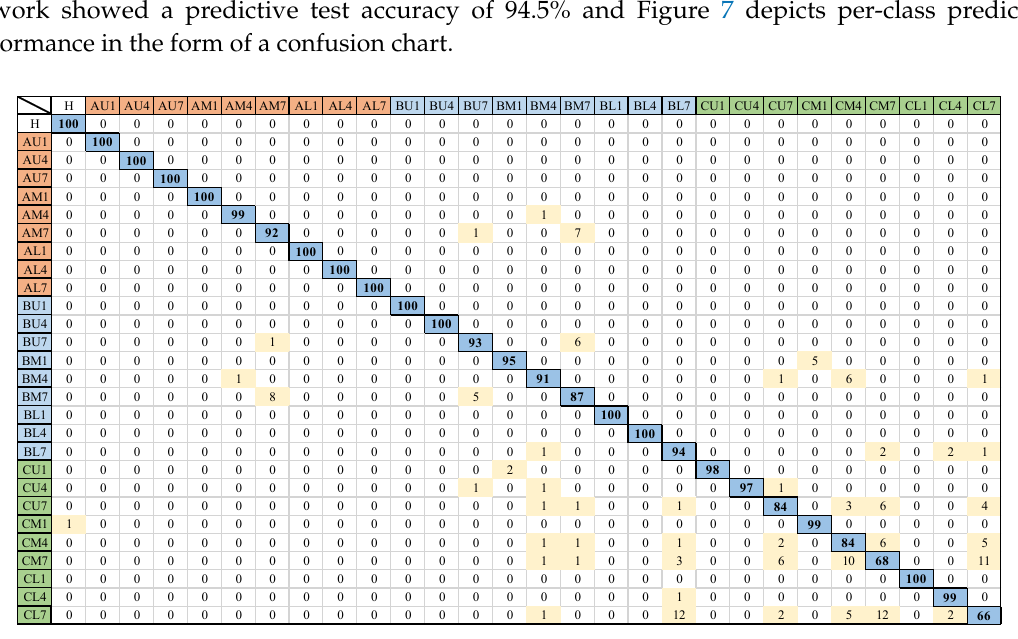
Figure 7. Confusion matrix of the pre-trained convolutional neural network (CNN) on unseen test data.